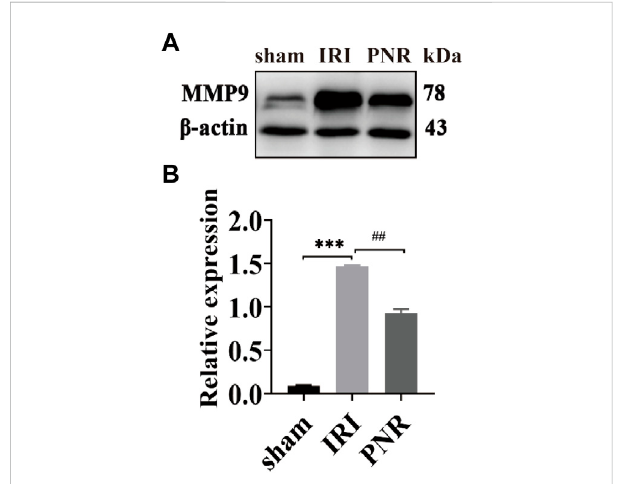
FIGURE 6 Results of MMP9 protein expression in kidney tissues at day 1 postoperatively (N = 3). (A) Protein bands for each group of MMP9 and β -actin detected by WB. (B) MMP9 protein expression in the kidneys of each group. Compared with the sham group, *** p < 0.001; compared with the IRI group, ## p <